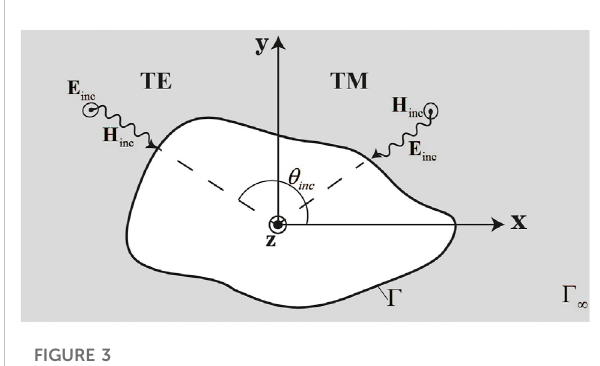
FIGURE 3 Diagram of TE- and TM-polarized fi eld: TE-polarized electric fi eld only has a z component and TM-polarized electric fi eld has x and y